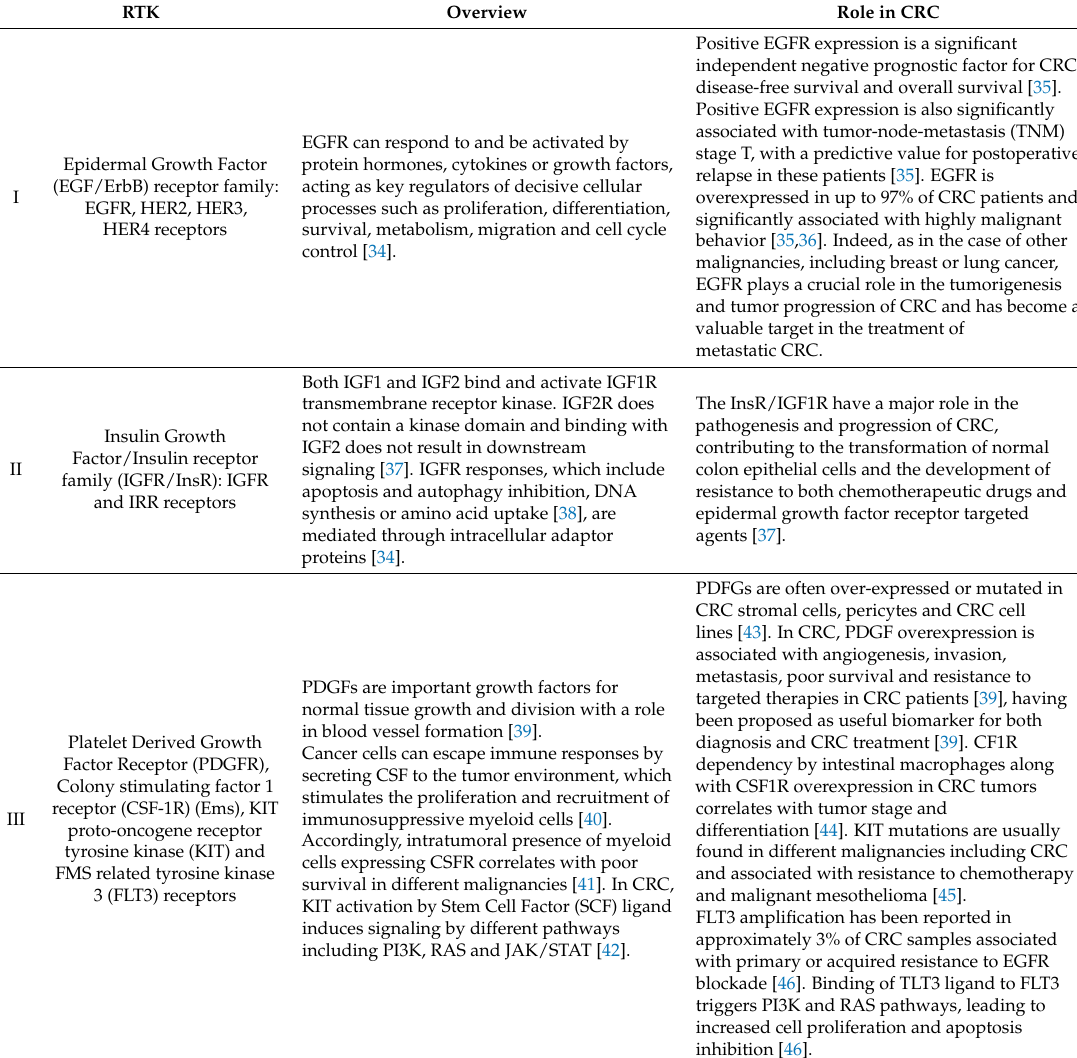
Table 2. Receptor Tyrosine Kinase (RTK) Subfamilies classification based on kinase domain sequence and their role in colorectal cancer. RTK Overview Role in